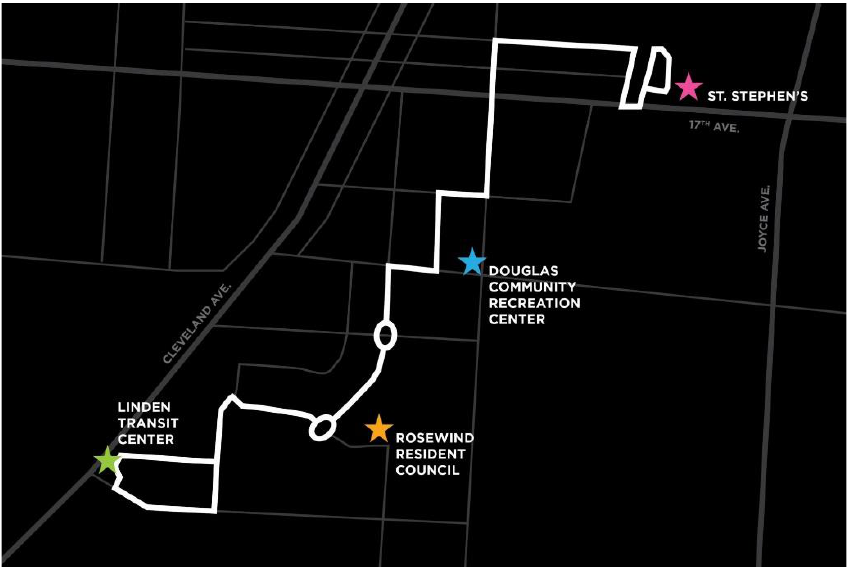
Figure 1. Deployment route for Linden LEAP [15].